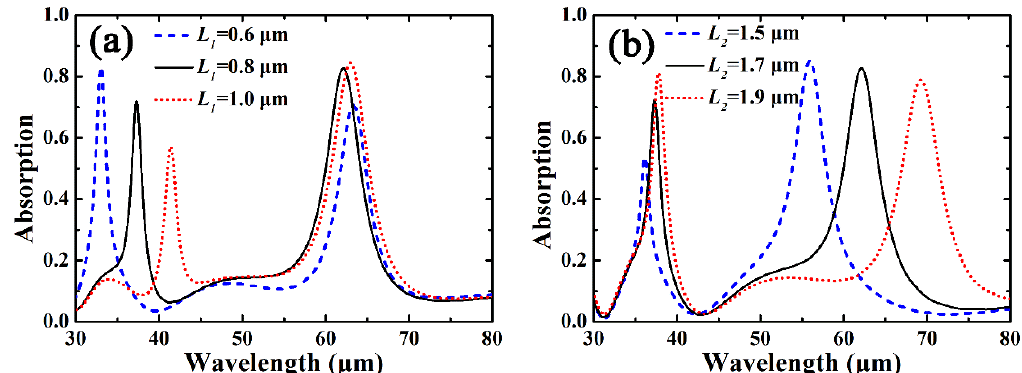
Figure 6. ( a ) Influence of width L 1 on the absorption performance of the cross-shaped graphene arrays. ( b ) Influence of length L 2 on the absorption performance of the cross-shaped graphene arrays.